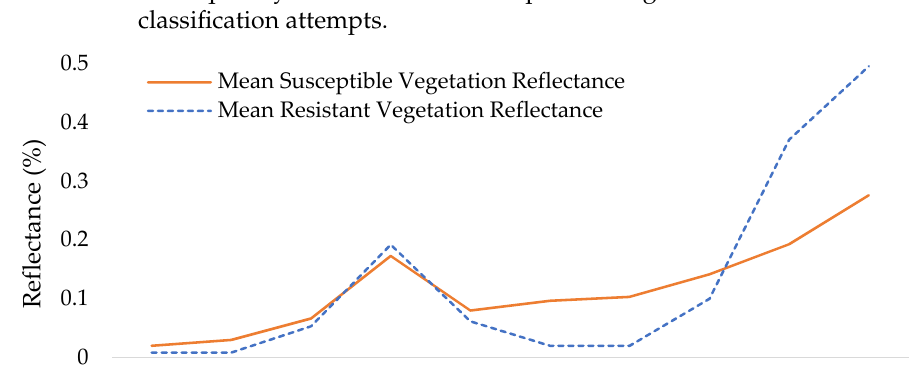
Magnitude of Resistance: 0 = Dead Plants 5 = Alive Plants with no Symptoms. The comparison between the reflectance of glyphosate-resistant vegetation and glyphosate-susceptible vegetation at each of the ten bands provided by the Red-Edge MX Dual Camera system can be seen in Figure 4. Wavelengths 842 nm, 705 nm, and 740 nm from the Red-Edge MX Dual Camera System were selected because large differences in reflectance were found at these wavelengths between glyphosate-resistant vegetation and glyphosate-susceptible vegetation. Wavelengths 842 nm, 740 nm, and 705 nm were subsequently used to create a composite image that served as a third image dataset for classification attempts.